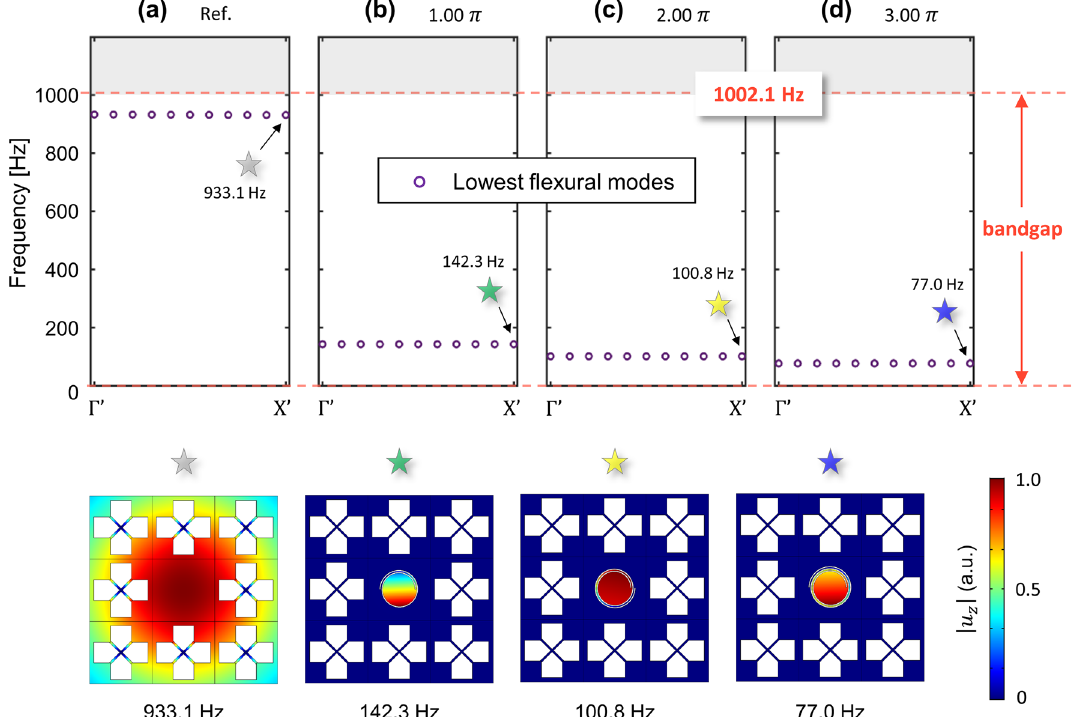
Figure 9. Band-structure by the supercell analysis for elastic foundation metamaterials with spiral cavities when t c is 0.5 mm. ( a ) Reference cavity without the spiral path. ( b ) The angle of the spiral path is 1 π , ( c ) the angle of the spiral path is 2 π , and ( d ) the angle of the spiral path is 3 π